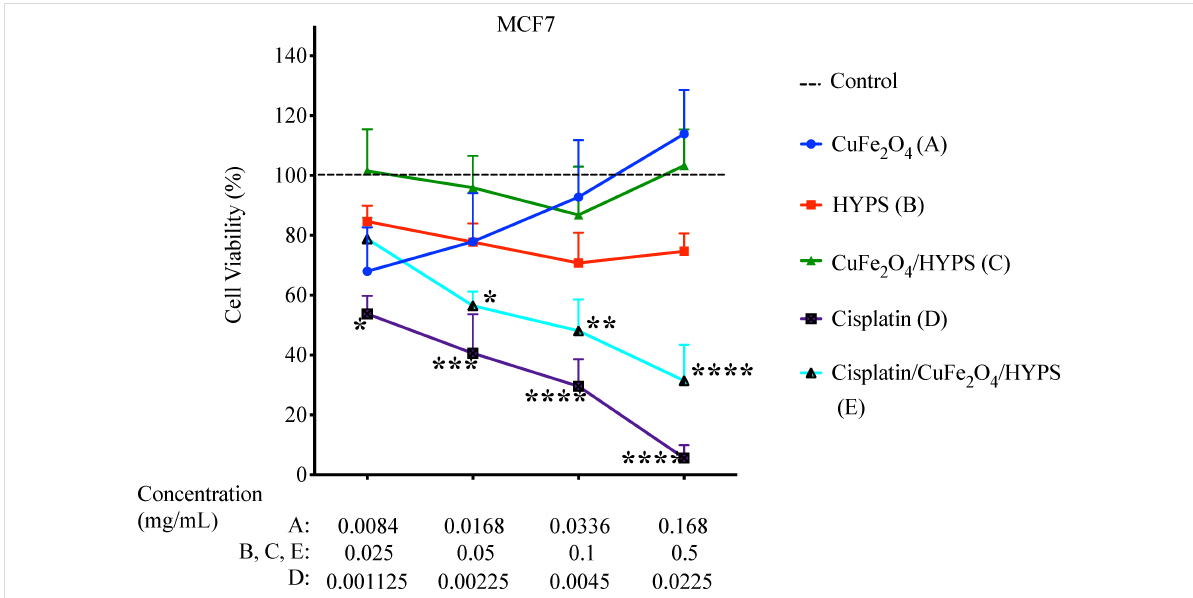
Figure 8: Percentage cell viability using MTT assay on the MCF-7 cell line. The cells were treated with the following formulations for 48 h: CuFe 2 O 4 (A), HYPS (B), CuFe 2 O 4 /HYPS (C), cisplatin (D), and cisplatin/CuFe 2 O 4 /HYPS (E). The treatment concentrations used were as indicated in the figure. The reason for the different concentrations of CuFe 2 O 4 and cisplatin is because they correspond to the amount adsorbed on the cisplatin/ CuFe 2 O 4 /HYPS nanoparticles. For details, please see the Materials and Methods section. n = 4 independent experiments. Dashed line represents untreated control. Error bars ± standard error of the mean (SEM) and * p < 0.05; ** p < 0.01; *** p < 0.001; **** p < 0.0001 versus